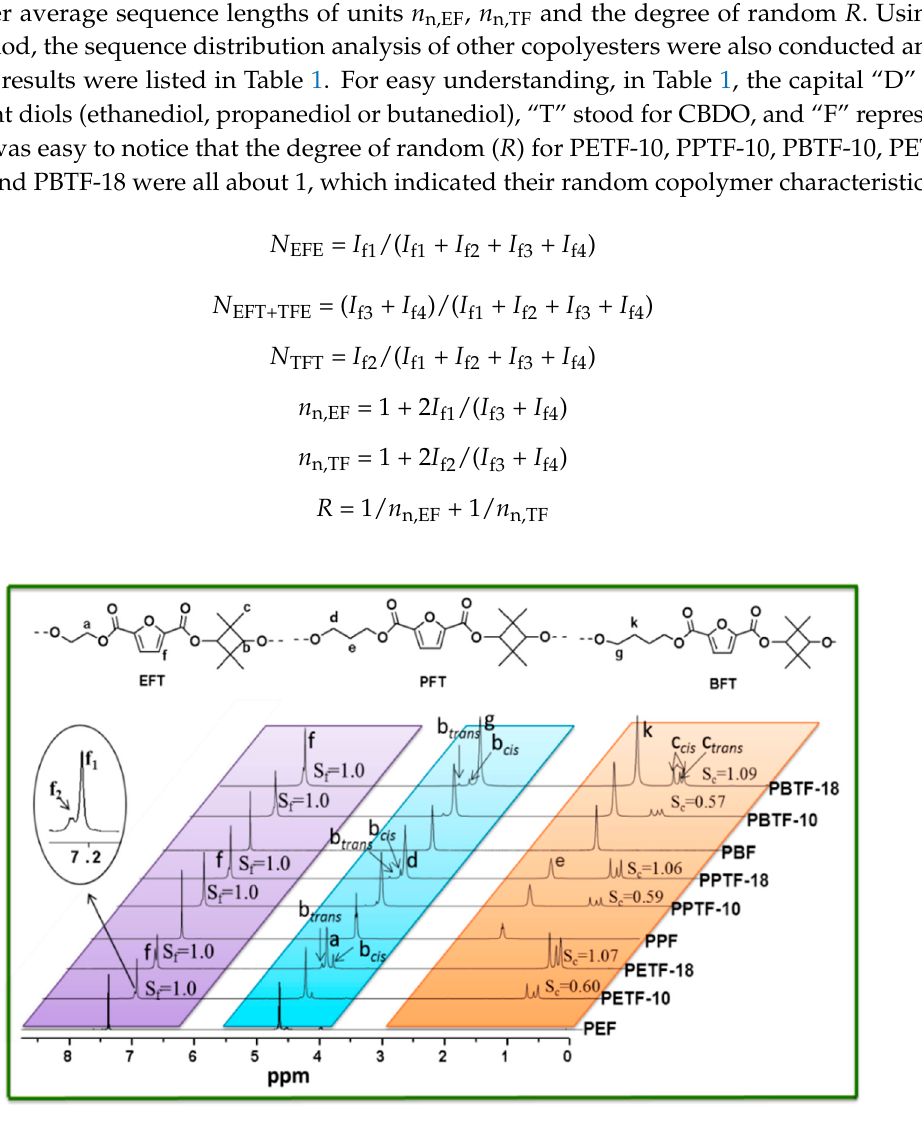
Figure 1. The 1 H NMR spectra of PEF, PPF, PBF, and the copolyesters modified with CBDO.